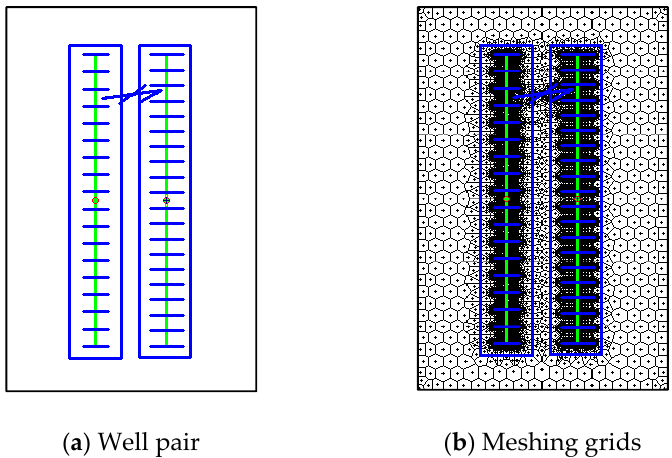
Figure 5. Mechanism model of two adjacent shale gas wells.